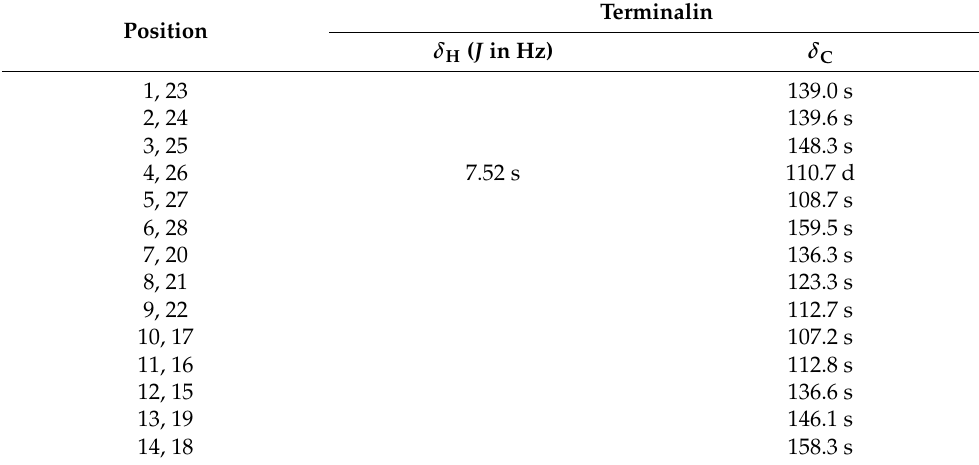
Table 1. 1 H (800 MHz) and 13 C NMR (200 MHz) data of terminalin in DMSO- d 6 ( δ ppm) a